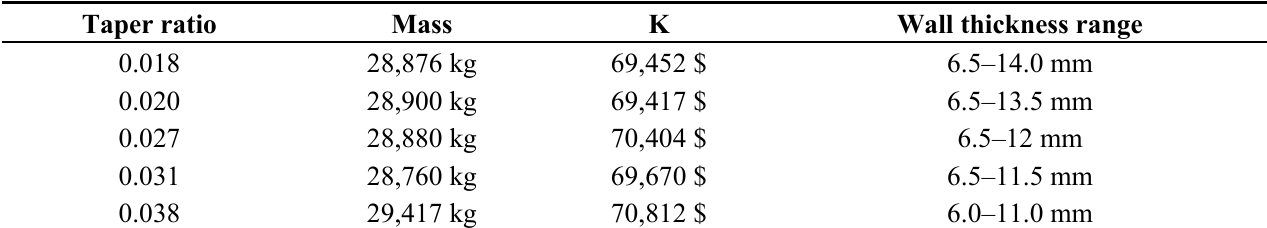
Table 9. Optimization results depending on the taper